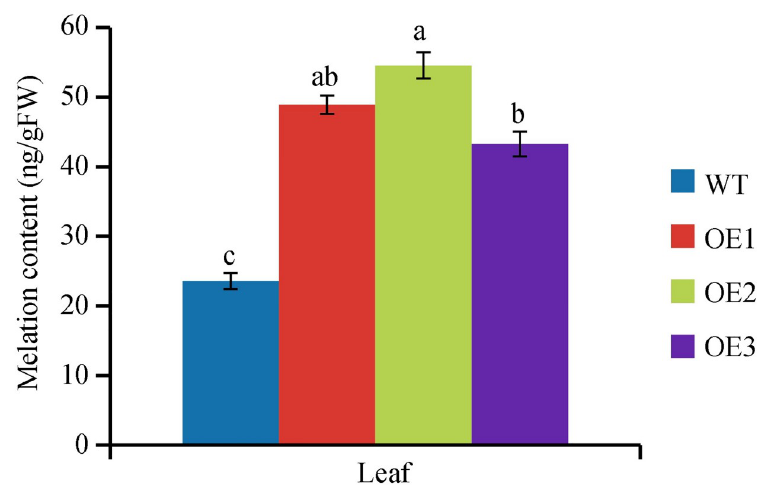
Fig 4. Melatonin content in WT and transgenic